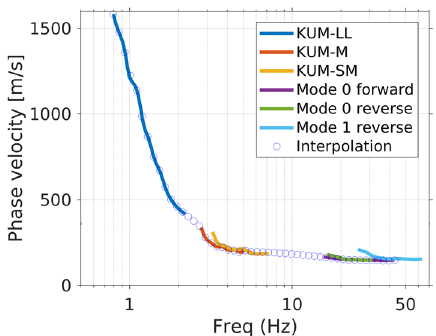
Fig. 5 Dispersion curve; Broadband fundamental mode Rayleigh wave phase velocity dispersion curve created by combining different arrays and MASW analysis (blue dots). Small portion of higher mode energy is picked from one shot gather downline, though not used in the inversion for Step 1 and Step 4